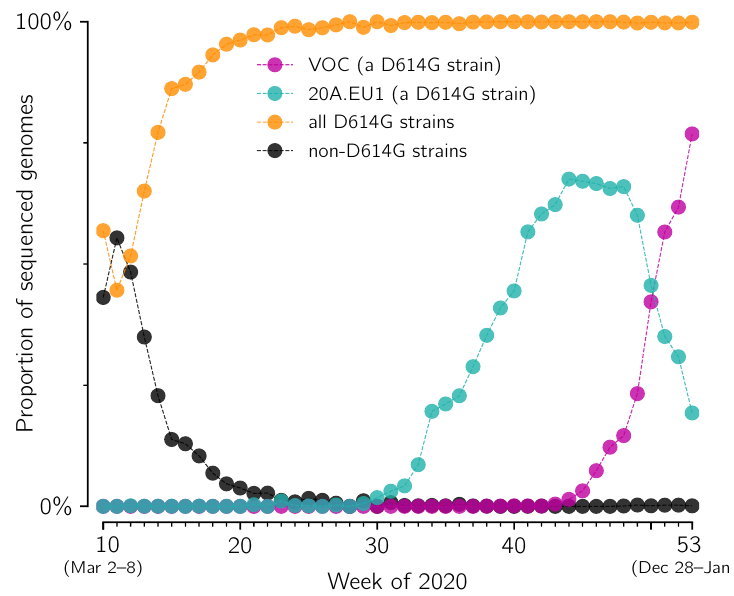
Figure 1. Fixation of D614G strain and competition between its substrains: 20A.EU1 and the VOC in England. The proportion of D614G (orange), 20A.EU1 (cyan), VOC (magenta) and D614 strains (black) in weeks 10–53 of 2020 has been determined based on GISAID data available on 12 February 2021 (provided in Supplementary Data File